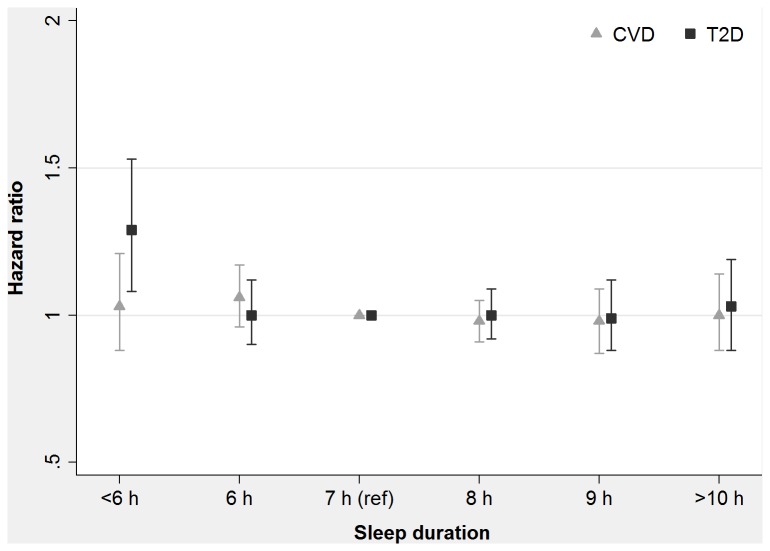
Hazard ratio for incident cardiovascular disease (CVD) and type 2 diabetes by sleep duration category in the 45 and Up Study.The plots shows hazard ratios with 95% confidence intervals for the specified category of sleep duration, compared with 7 h, after adjusting for potential confounders. Analyses excluded individuals reporting any serious illness at baseline (cancer, heart disease, stroke or diabetes).